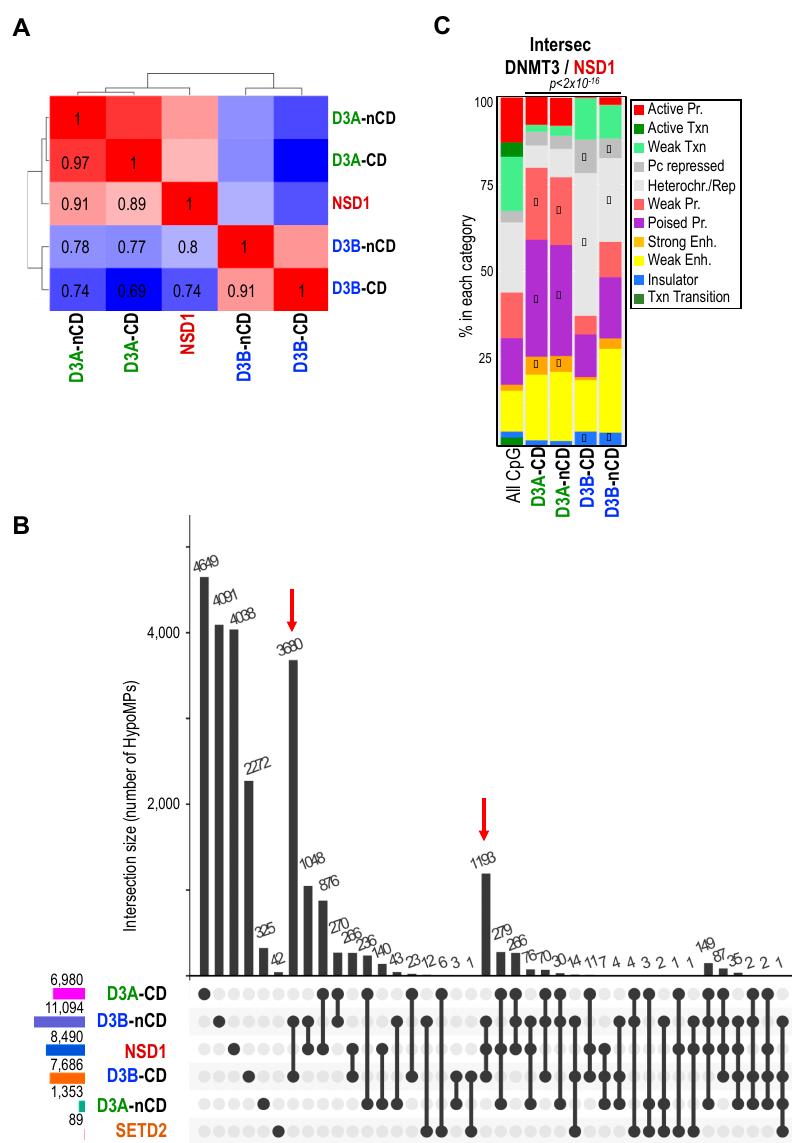
Figure 4. Shared hypomethylated sites between patients with mutations in DNMT3 enzymes and H3K36me2 KMT. ( A ) Pairwise Pearson correlation between patients with mutations in NSD1 or in DNMT3 enzymes based on HypoMPs were identified in NSD1 mutants ( n = 8490). The colors of the heat map range from high correlation in red to low correlation in blue. The pairwise index is indicated on the heat map. ( B ) Quantitative visualization of HypoMPs overlap between groups of patients was done using UpSet plot (R version). The bottom left horizontal bar graph shows the total HypoMPs identified in patients with mutations in the catalytic (CD) or non-catalytic (nCD) domains of DNMT3A or DNMT3B, and in the H3K36 KMTs NSD1 and SETD2. The circles in each panel’s matrix represent what would be the different Venn diagram sections (unique and overlapping DMPs). Connected dots indicate intersection of HypoMPs between groups. The top bar graph in each panel summarizes the number of HypoMPs for each unique or overlapping combination. ( C ) Epigenomic annotation of the HypoMPs shared between patients with mutations in NSD1 or DNMT3 catalytic (CD) or non-catalytic (nCD) domains as in Figure 2A. p -values (p, Chi-square test) assess significant changes in the distribution of HypoMPs within the different categories relative to HM450K array composition. The diamond symbol denotes categories that contribute the most to the p -values based on the standardized